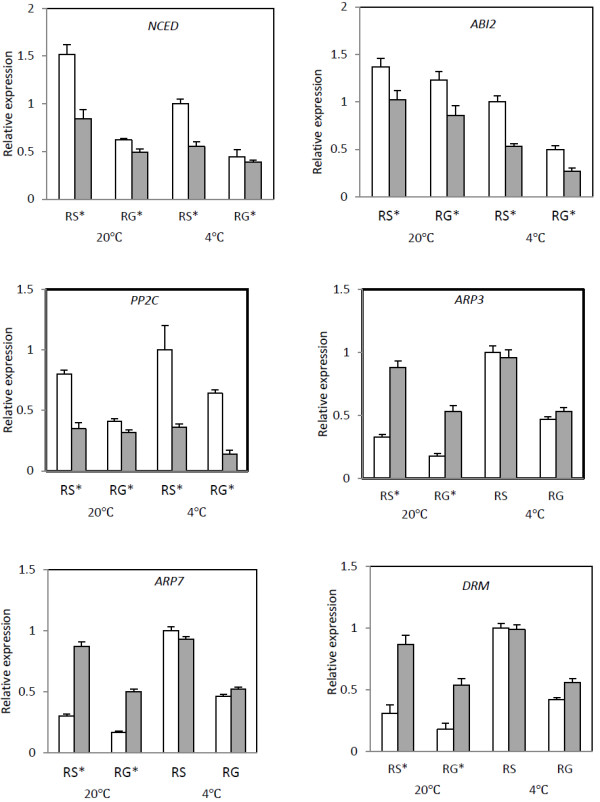
Relative expression levels analysis of transcripts negatively associated with dormancy release (NCED, ABI2, PP2C, ARP3, ARP7, DRM) levels in the Embryo (Em□) and endosperm (En■) under warm (20°C)/cold (4°C) seed stratification process. RS, radical just sprouted; RG, radical growing up to 2 cm. Expression is shown relative to GAPDH as the reference gene. RNA was extracted from three biological samples and qRT-PCR was performed. Data represent means ± SD. * indicate a significant difference between Em and En at P < 0.05.